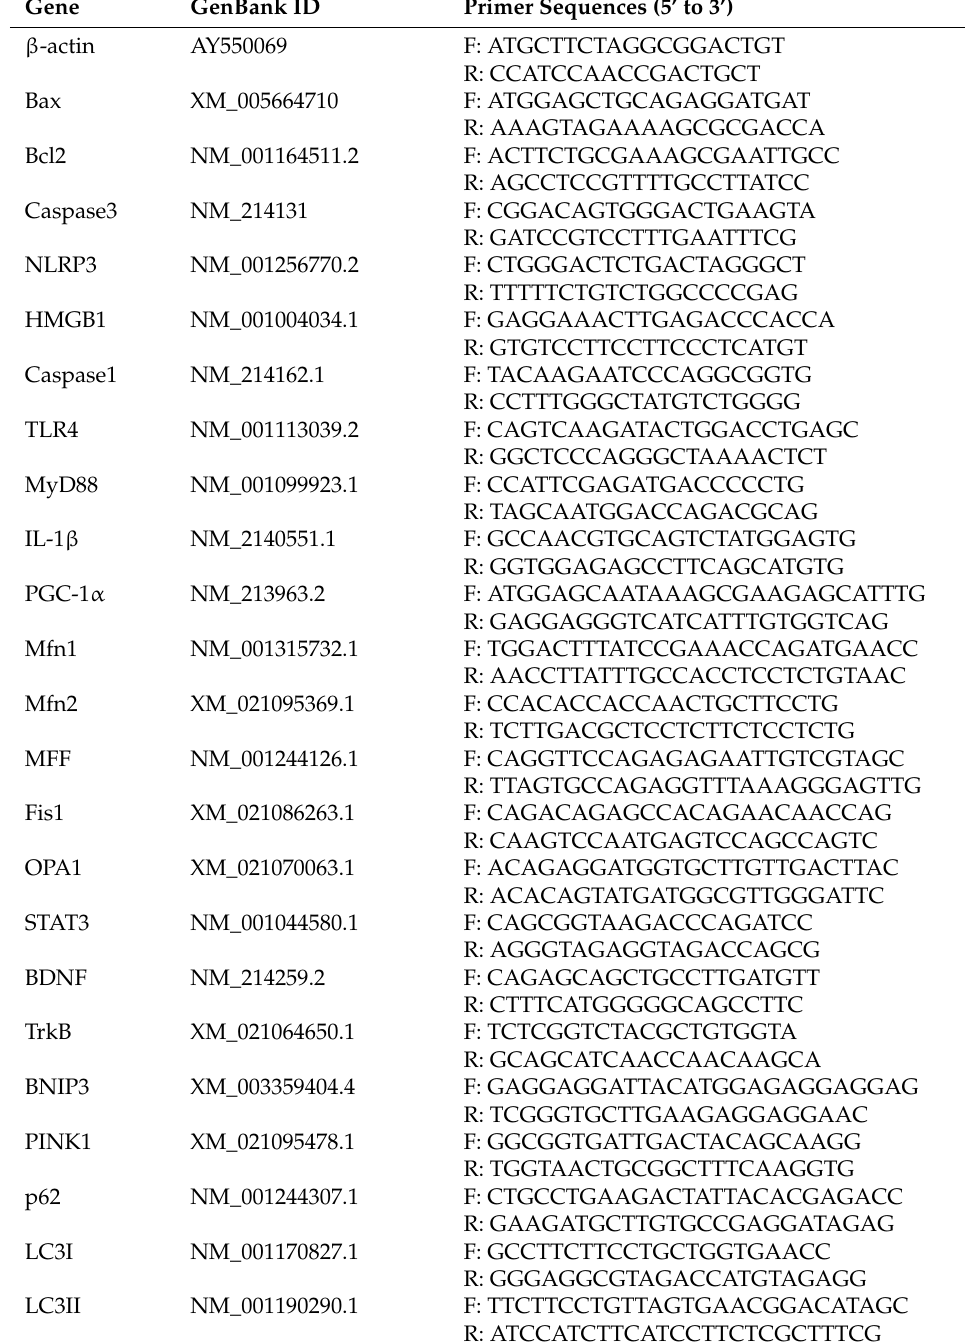
Table 3. The real-time PCR